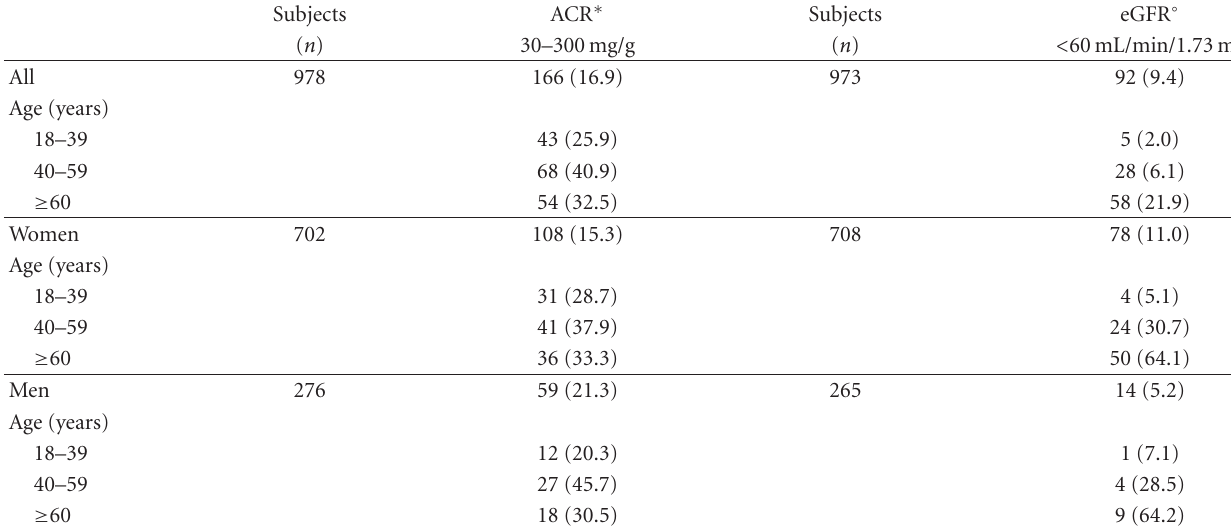
Table 3: Prevalence of microalbuminuria and decreased